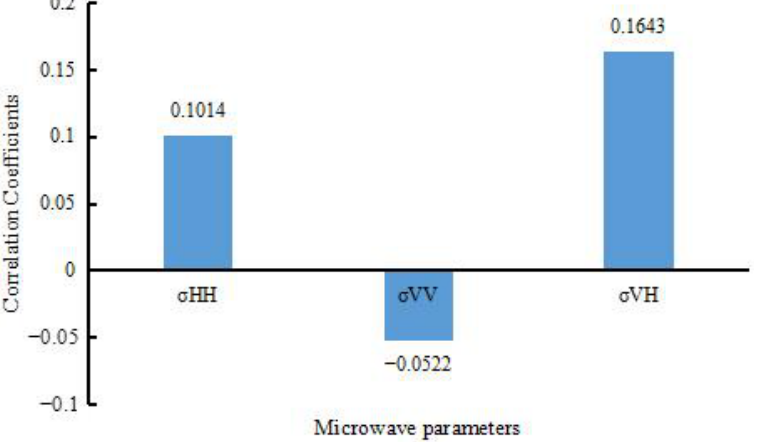
Figure 8. The correlation coefficients between microwave-polarization modes and SMC g.